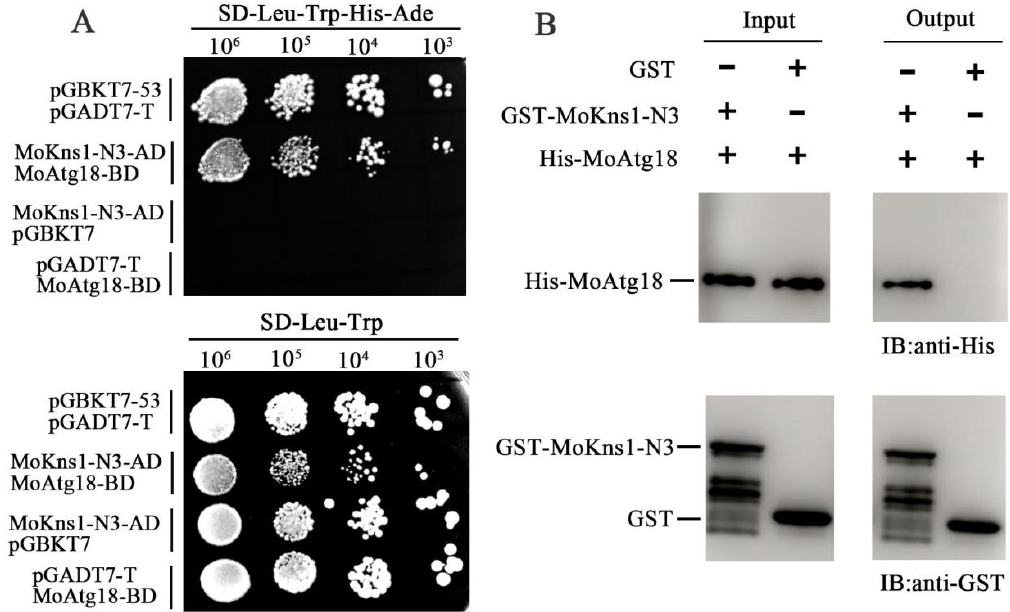
Figure 4. MoKns1–N3 interacts with MoAtg18. ( A ). Yeast two − hybrid analysis. The pair of plasmids pGBKT7 − 53 and pGADT7 − T was used as the positive control. Plates were incubated at 30 °C for 3 days before being photographed. ( B ). Pull down assays. The recombinant GST–MoKns1–N3 or GST bound to glutathione Sepharose beads was incubated with E. coli cell lysate containing His– MoAtg18. Eluted proteins were analyzed by immunoblot (IB) with the monoclonal anti–His and anti − GST antibodies.